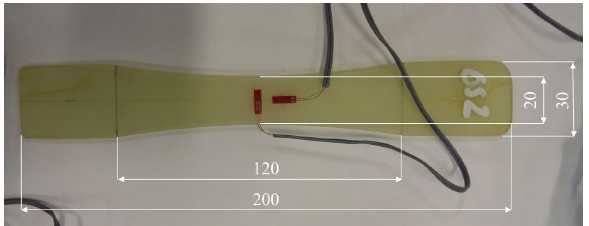
Figure 1: Geometry of dogbone specimens used for static tensile and fatigue tests. The placement of strain gauges is